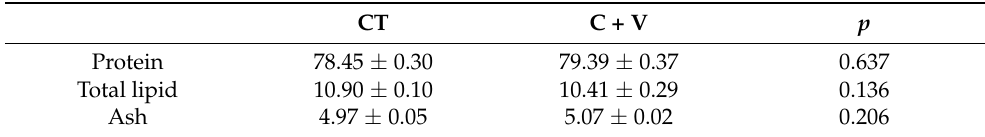
Table 4. Muscle proximate composition (% dry weight) of juvenile C. labrosus fed the control (CT) and C. fusca + V. proteolyticus (C + V) diets for 90